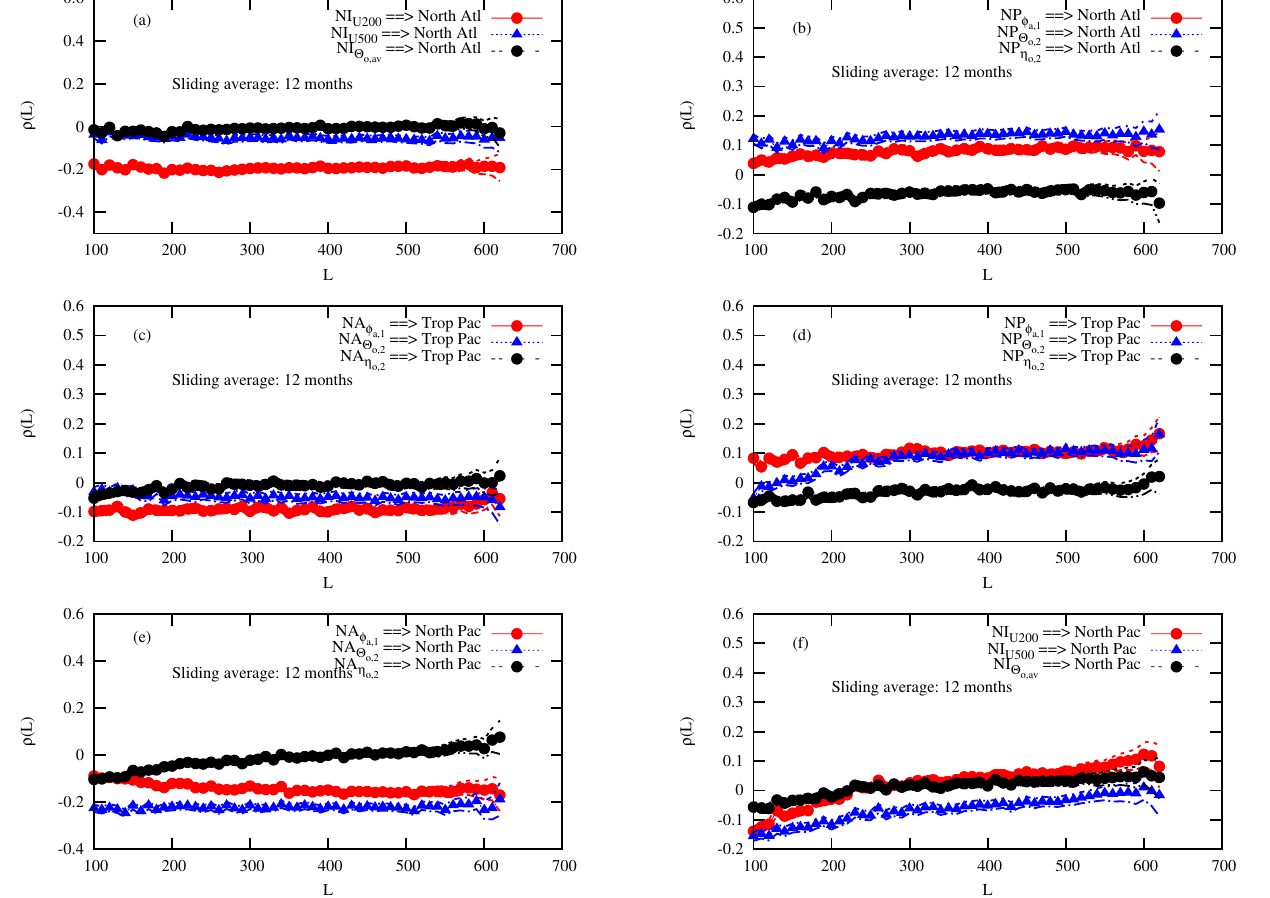
Figure 7. CCM as a function of the length L of the samples, as obtained from the series of Fig. 2 after averaging over a sliding window of 12 months for the ERA-20C and ORAS4 reanalyses. Each line with symbols corresponds to the influence of one variable on a specific coupled ocean–atmosphere basin. The specific variables are denoted in the caption corresponding to each line in each